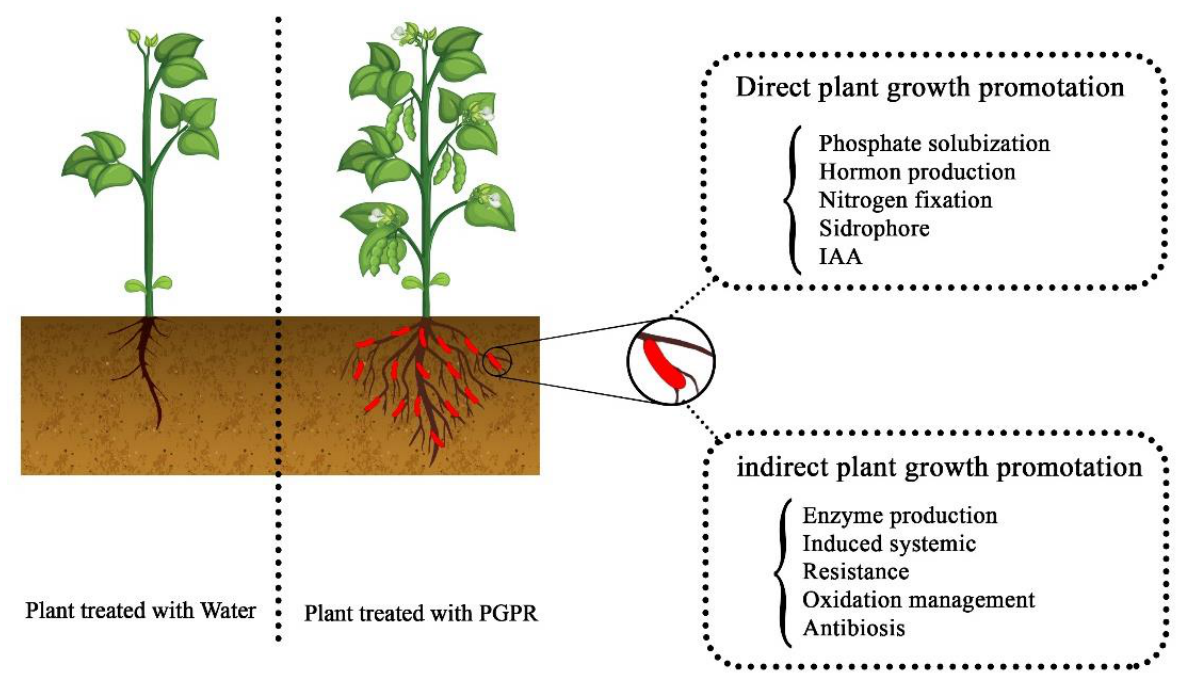
Figure 6. Interaction between plants and plant growth-promoting rhizobacteria.